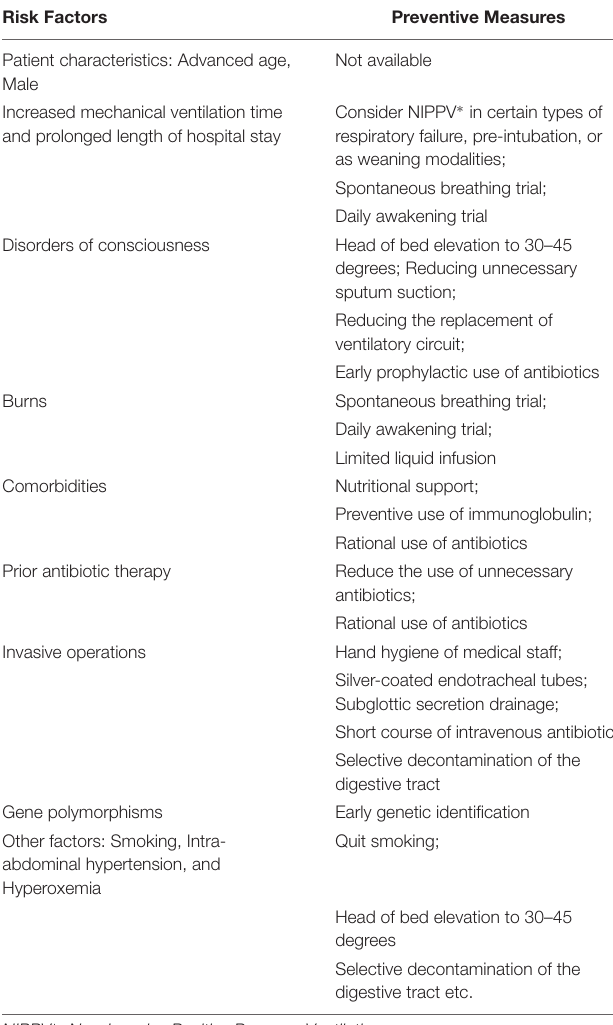
TABLE 1 | Specific preventive measures for the occurrence of various risk factors of ventilator-associated pneumonia